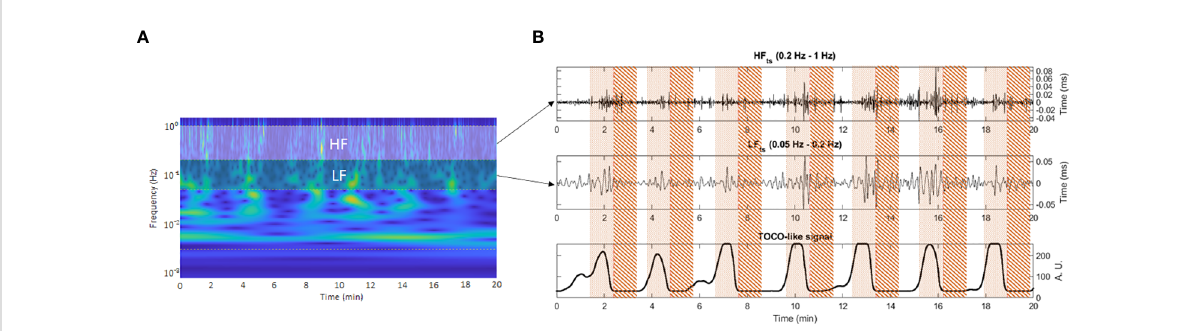
FIGURE 2 Window segmentation of 50 seconds on the representative frequency bands time series. Pointed area: contraction interval of study. Striped area: quiescent interval of study. Panel (A) shows the frequency band delimitation on the time-frequency representation of the R-R time series. Panel (B) shows contraction and quiescent analysis window delimitation over the frequency bands time series (upper and middle subplots) aligned with the TOCO-like signal (lower